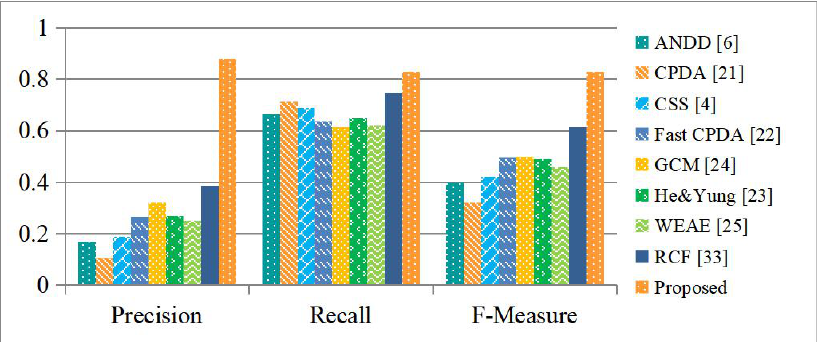
Figure 9. Evaluation results of different corner